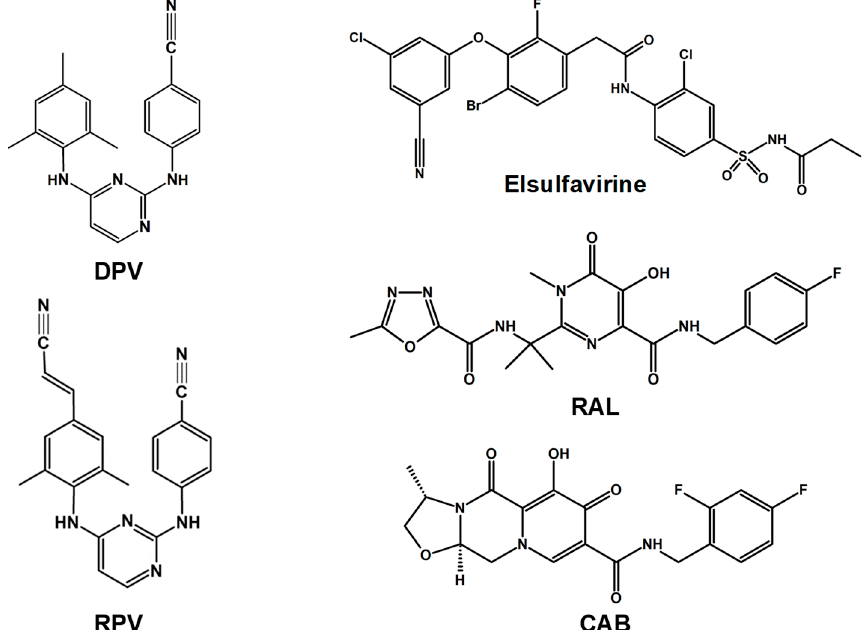
Figure 2. Non-nucleoside reverse transcriptase inhibitors (NNRTIs) and integrase strand transfer inhibitors (INSTIs) in clinical trials and preclinical development as LA antivirals.